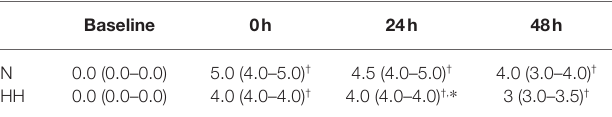
TABLE 2 | The muscle soreness measured before preconditioning and post- exercise in N and HH trials.